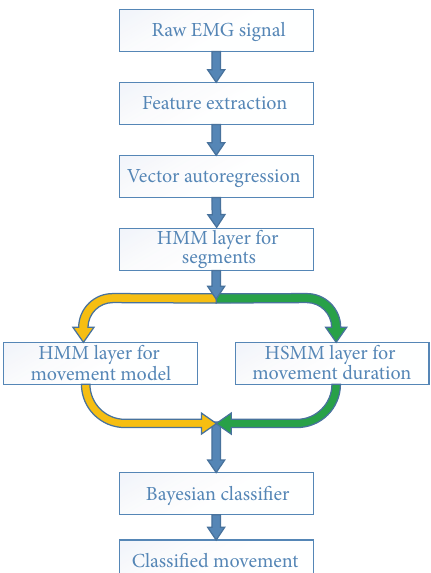
Figure 4: VARHHMM flowchart. At the hierarchically higher HMM layer, the two algorithms are split before the Bayesian infer- ence layer. While one algorithm for HMM (orange path) is the same as the HMM for segments, the other algorithm is based on hidden semi-Markov model (HSMM) paradigm that incorporates movement duration as a free parameter.